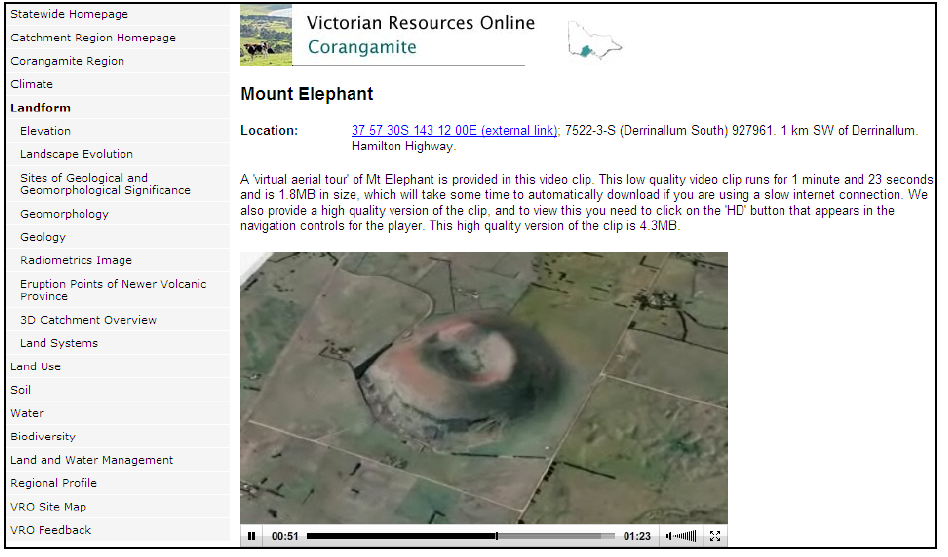
Figure 16. Webpage incorporating a landscape flyover video.  State of Victoria,